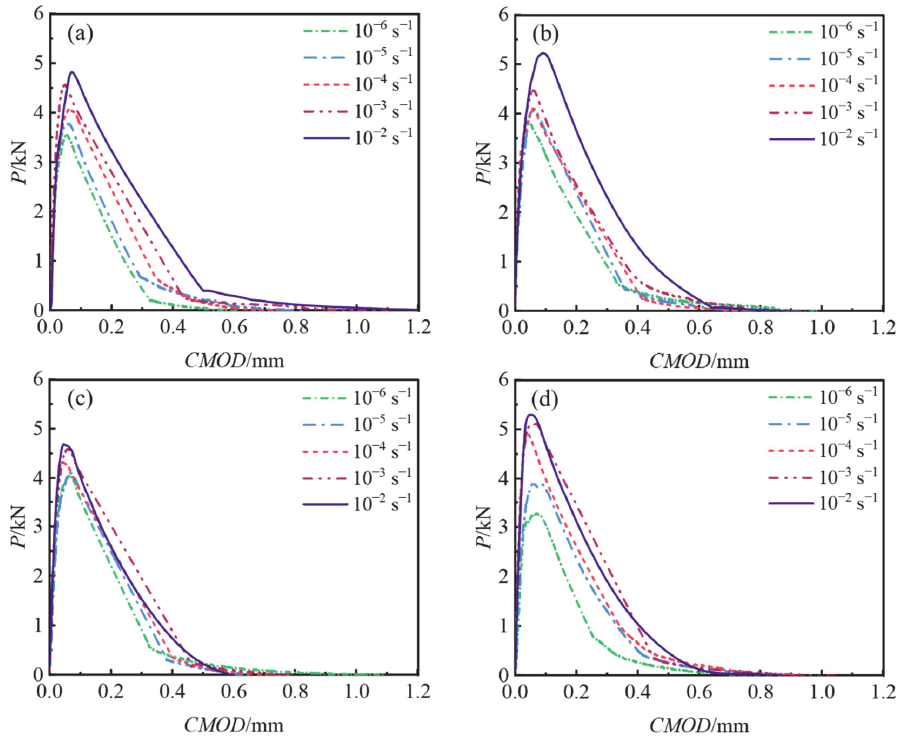
Figure 5. The P–CMOD curves under different loading rates: ( a ) OPC; ( b ) B ‐ 0.2; ( c ) B ‐ 0.4; and ( d ) B ‐